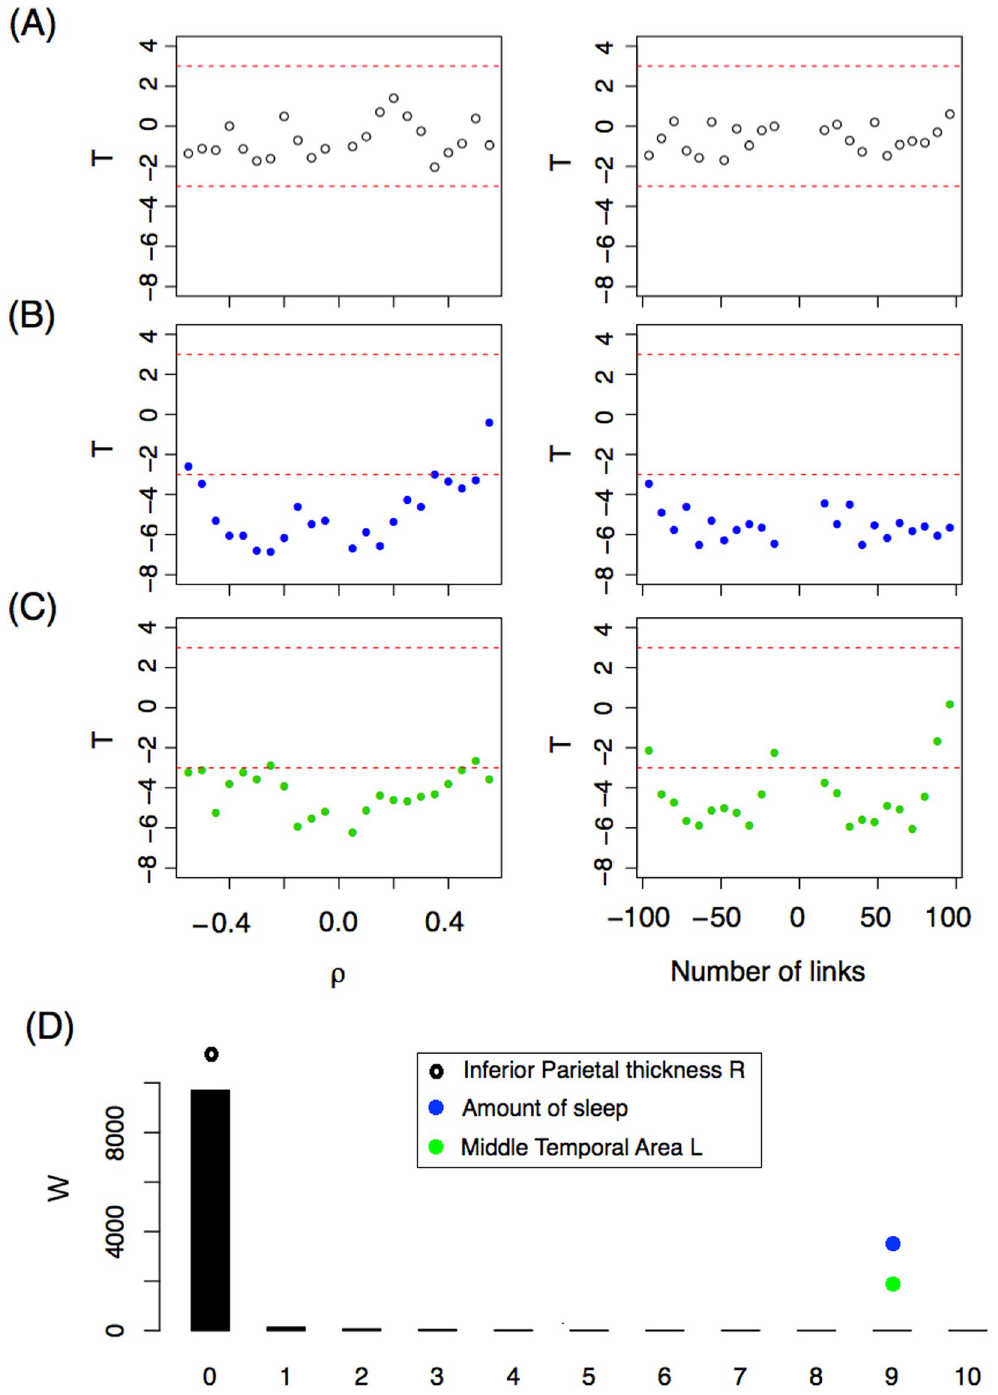
Figure 5. ( A – C ) T –statistics as a function of (left panel) ρ and (right panel) the number of links for three variables: ( A ) Right Inferioparietal Thickness, ( B ) Number of hours slept the nights prior to the scan. ( C ) Left Middle temporal Area. ( D ) W -statistic distribution (black bars) based on a bootstrap strategy. The W -statistic of the three variables studied is depicted with